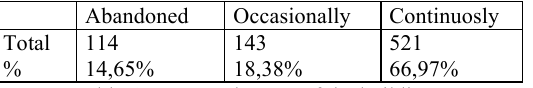
Table 4. Temporal usage of the buildings